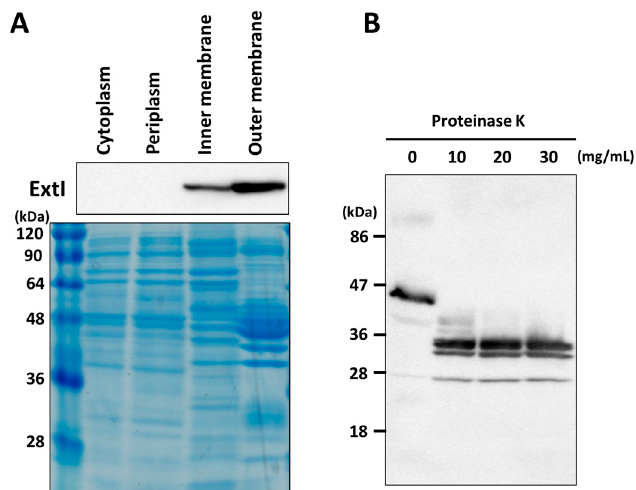
Figure 2. Cellular localization of ExtI. ( A ) Subcellular fractionation and Western blotting. Each cellular fraction was isolated, and the localization of ExtI was analyzed by Western blotting (upper panel). A Coomassie-stained gel is shown as the loading control (lower panel). The numbers at the left indicates the sizes of the marker proteins in kDa; ( B ) the effects of proteinase K treatment on ExtI integrity. Cells were treated with different concentrations (0 to 30 mg/mL) of proteinase K to analyze the surface exposure of ExtI, and the degraded products were analyzed by Western blotting.